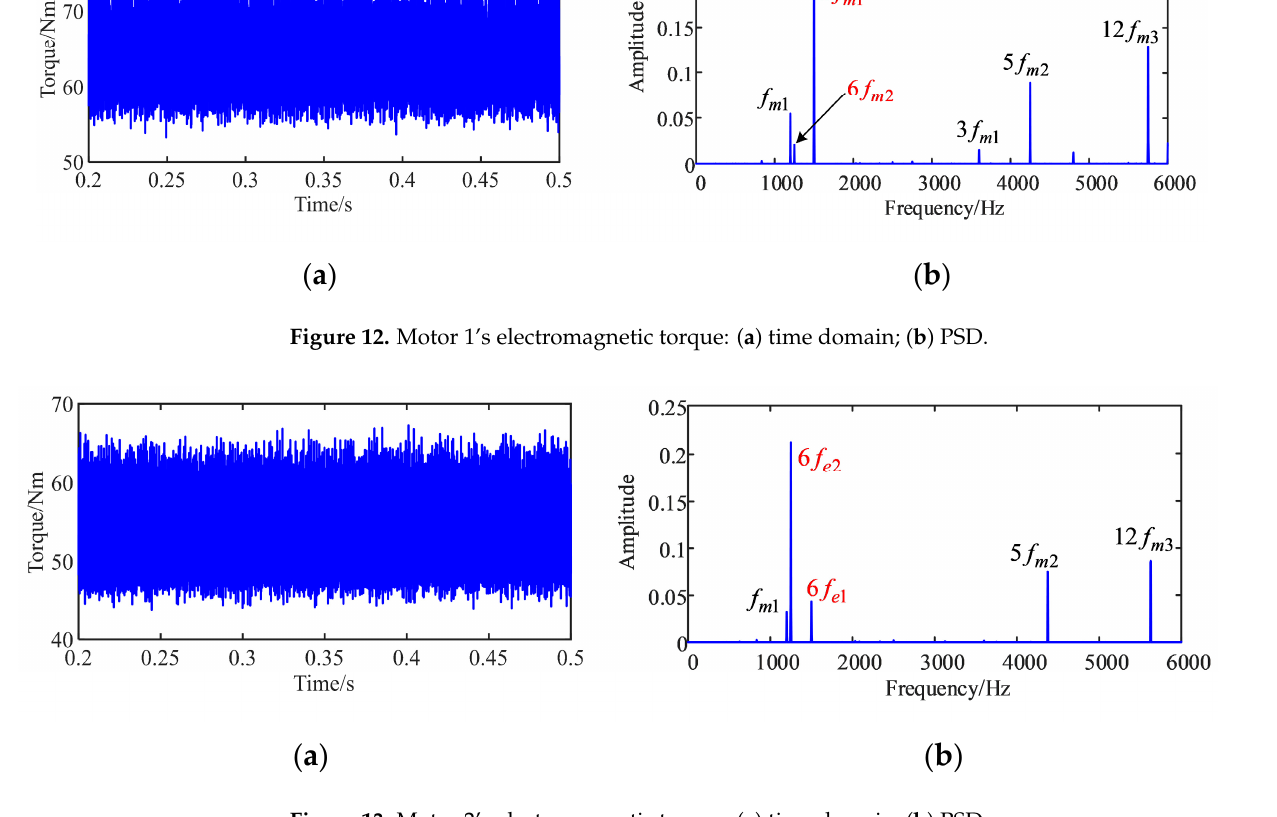
Figure 13. Motor 2’s electromagnetic torque: ( a ) time domain; ( b ) PSD. As can be seen from Figure 14b, the PSD of the meshing force of the first gear pair contains the sixth harmonic component of both motors, generated by the nonlinearity of the inverter in the dual-motor drive mode. It shows that the gear transmission system suffers from harmonic excitation from both motors in the dual-motor drive mode, which aggravates the fluctuation of the meshing force of the gear pair.